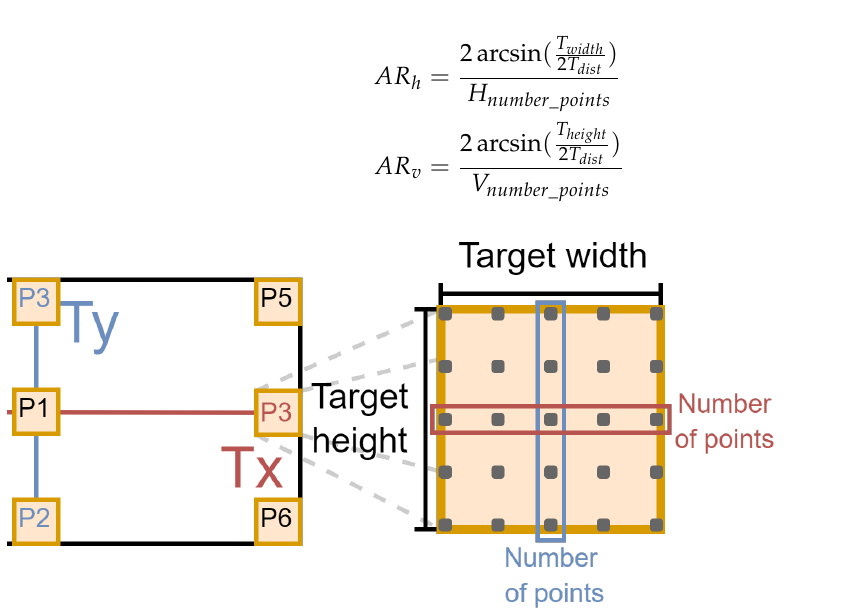
Figure 13. Points reflected by a known target.